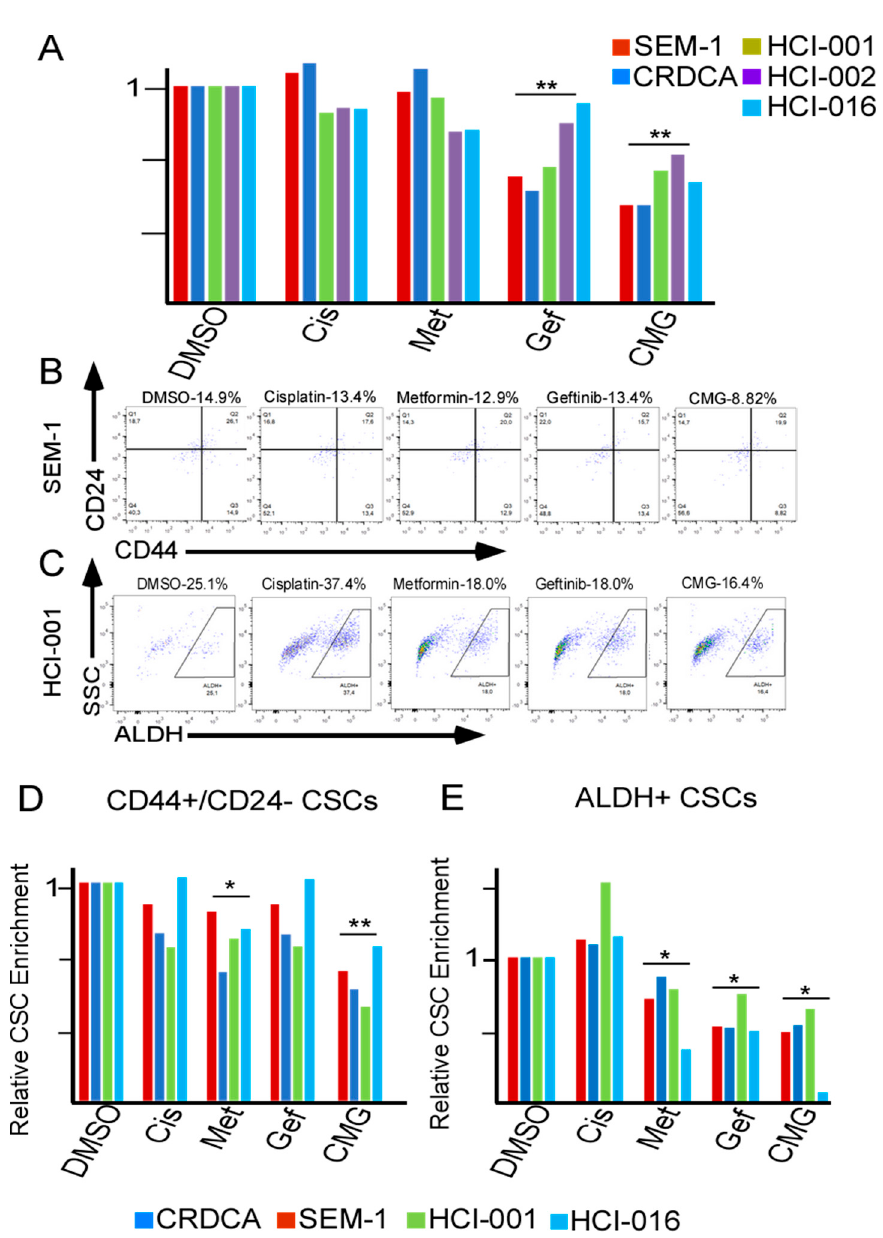
Figure 4. Co-inhibition of hypoxia and EGFR in combination with cisplatin effectively inhibits the viability of patient tumors and CSC populations in ex vivo organotypic cultures. ( A ) Alamar blue viability analysis of organotypic cultures from two primary patient TNBC tumors (CRDCA and SEM-1 samples) and three patient-derived xenograft samples (HCI-001, HCI-002, HCI-016) after 144 h of exposure to DMSO (vehicle control), cisplatin (Cis, 5 µM), gefitinib (Gef, 5 µM) and/or metformin (Met, 25 µM). ( B , C ) Representative flow cytometric plots of the CSC subpopulations (CD44+/CD24 − or ALDH+) in SEM-1 and HCI-001 cells after 144 h of treatment with the different drugs as described in (A). ( D,E ) Flow cytometric data of the relative living CSC (CD44+/CD24 − or ALDH+) populations in SEM-1, CRDCA, HCI-016 and HCI-001 patient TNBC tumors after 144 h of exposure to the drugs as described in (A). Each bar represents individual patient sample, n = 4–5 samples; * p < 0.05, ** p < 0.01.